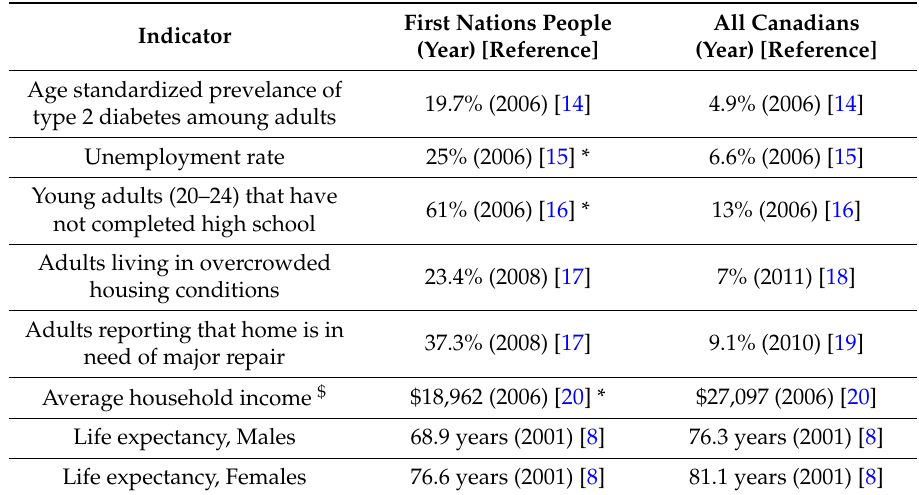
Table 1. Snapshot of disparities: Social, economic, and health indicators among First Nations peoples and non-First Nations people in Canada. First Nations Indicator